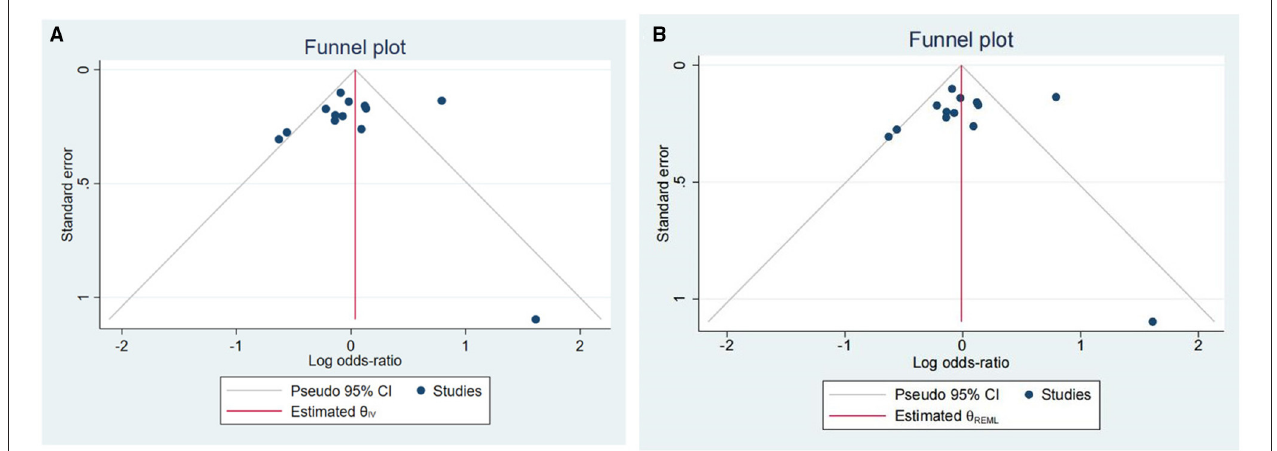
FIGURE 3 | Funnel plots of publication bias. (A) nonparametric trim and (B) fill method